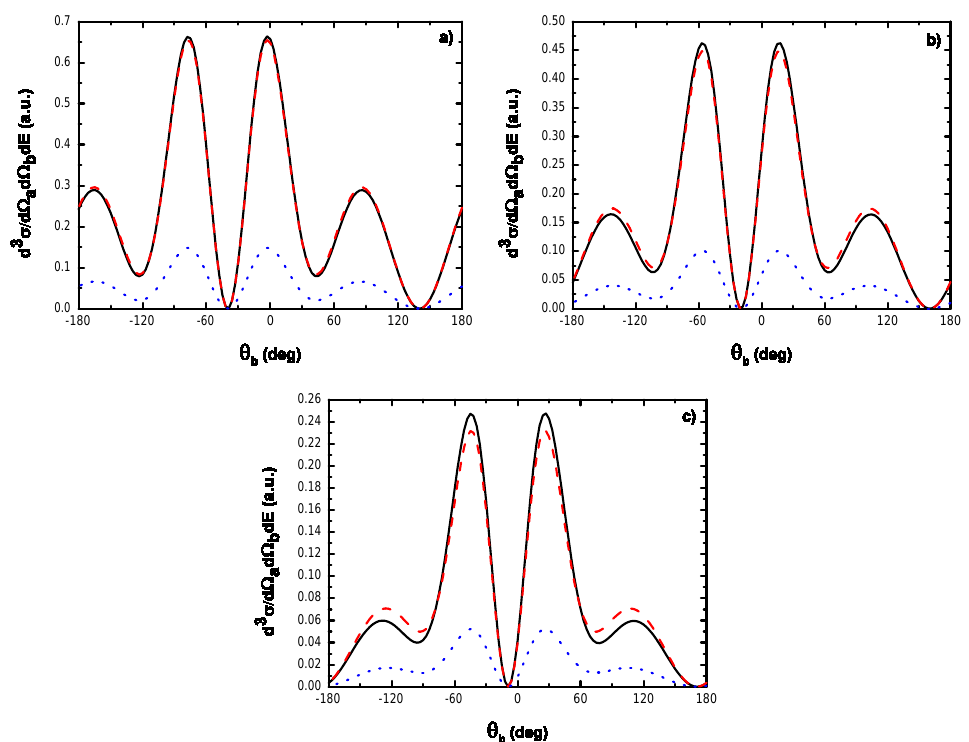
Figure 8. The same as in Figure 5, but the laser polarization vector is perpendicular to the momentum transfer ( ˆ ε ⊥ ∆ ) .